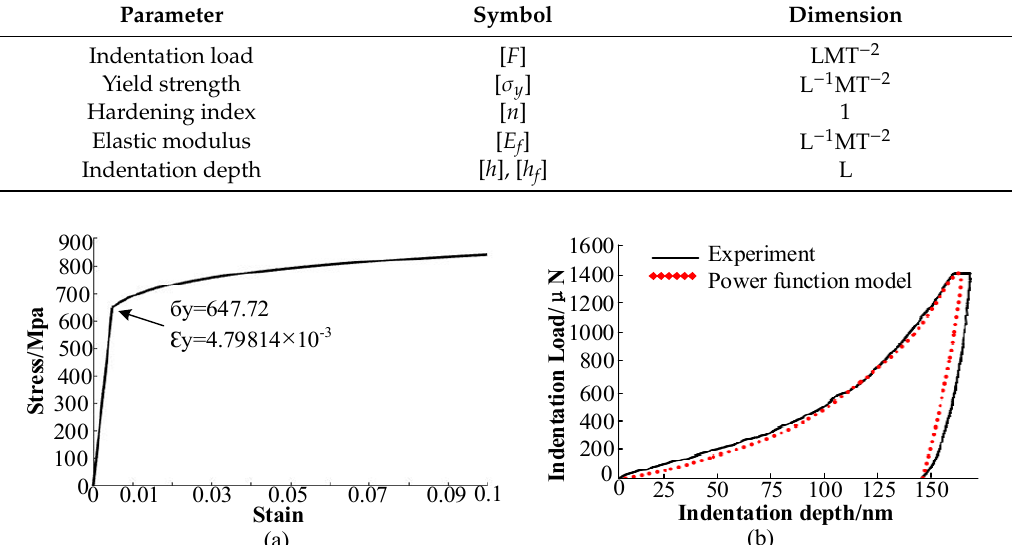
Table 2. Related parameters of Nano-indentation test.